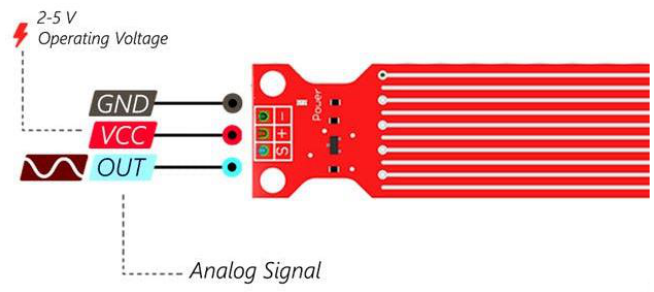
Figure 6. Water level sensor physical and connection diagram [35].